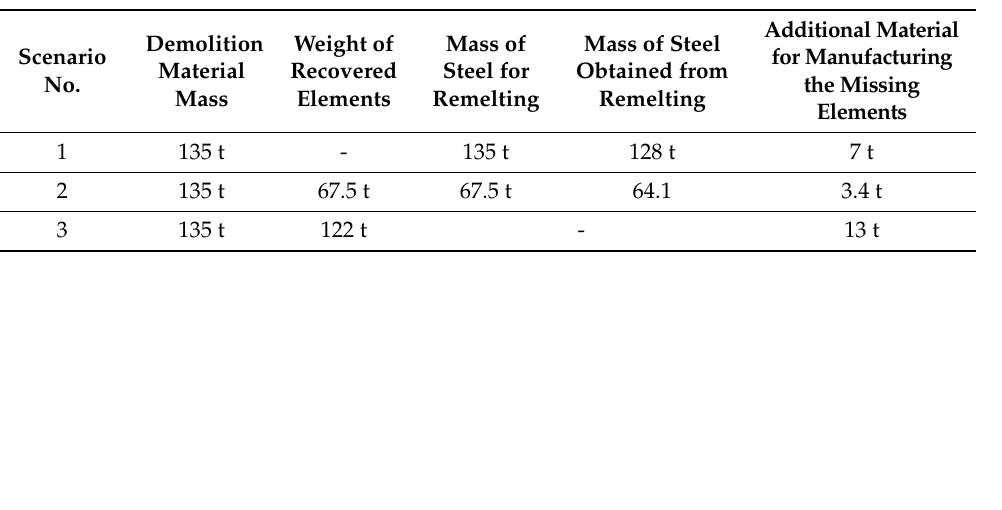
Figure 7. Scenario no. 3: Total reuse of the steel structure. The authors developed specialized processes such as the steel section refurbishment process. This process consists of washing the grid elements with pressurized water, sand ‐ blasting (cleaning the grid elements to grade Sa2½), and spray painting the grid elements